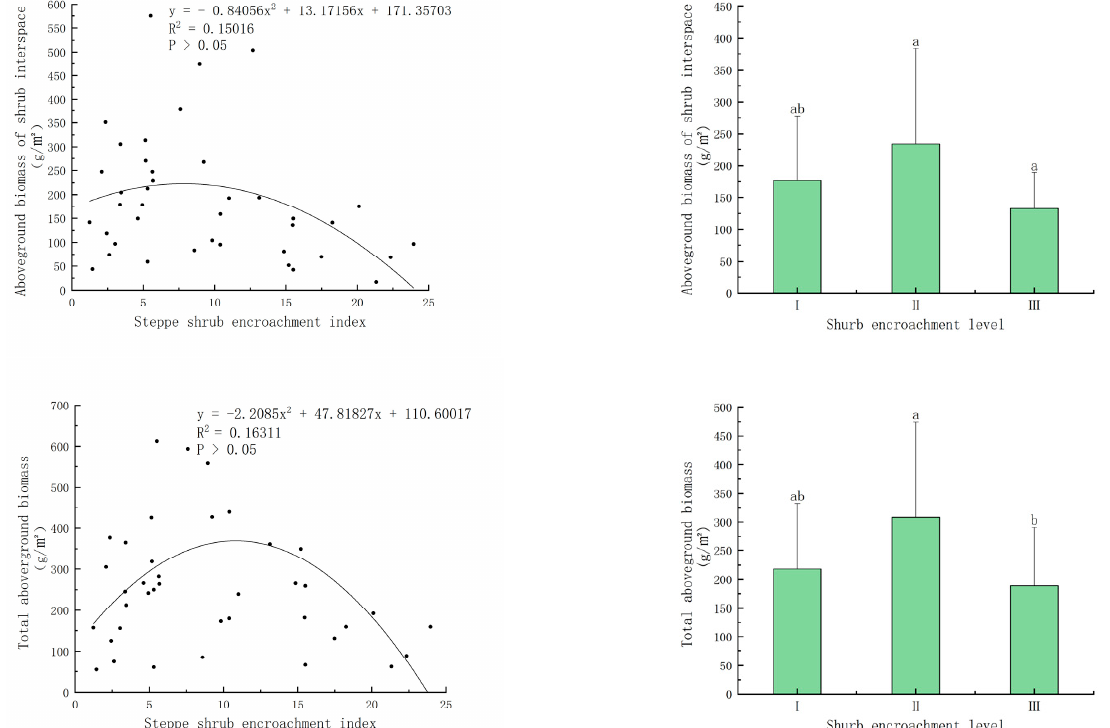
Figure 4. Relationship and difference in aboveground biomass at different shrub-level sites. Different lowercase letters indicate significant differences among sites ( p <